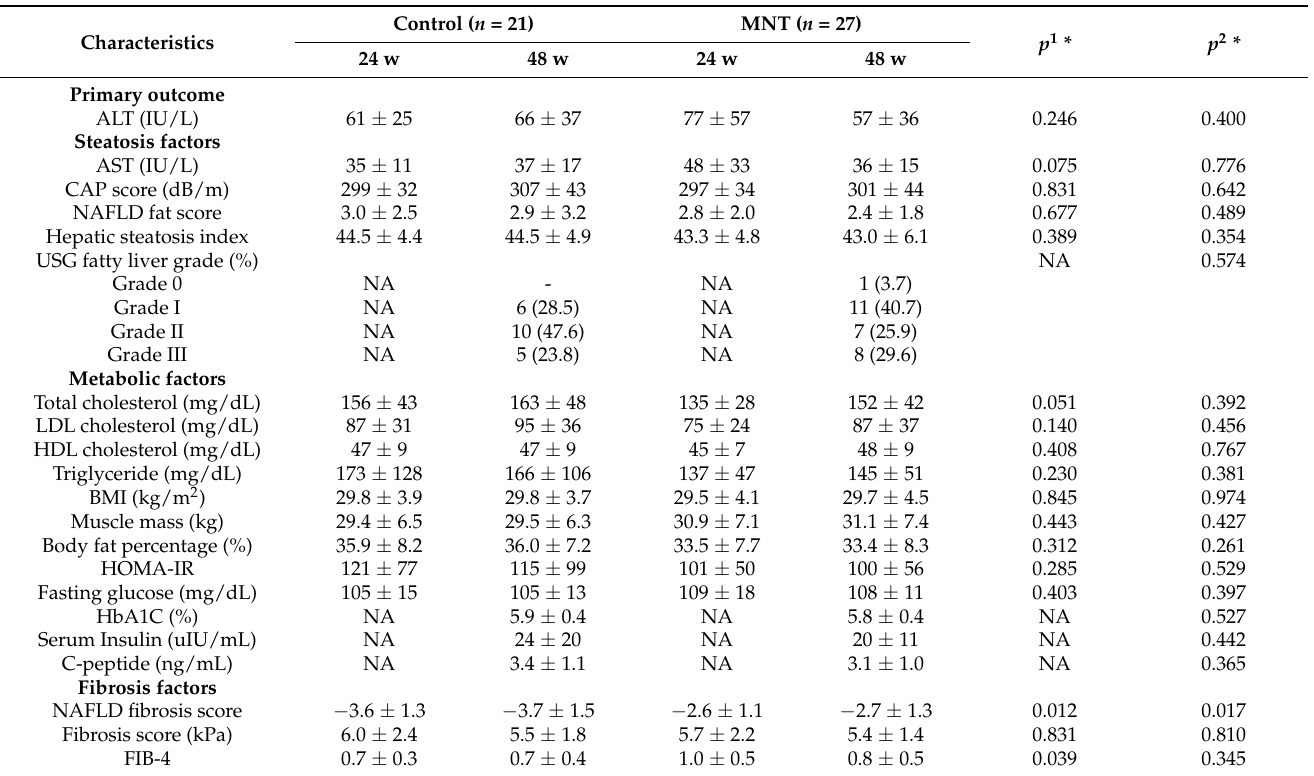
Table 3. Comparison of outcome values after 24 and 48 weeks between the control and MNT group.